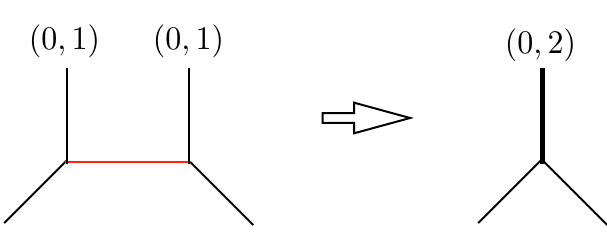
Figure 28. The red line is the curve of self-intersection see that two vertical external 5-branes are coincident | this con(cid:12)guration describes an isolated singularity in the corresponding 3-fold X 0